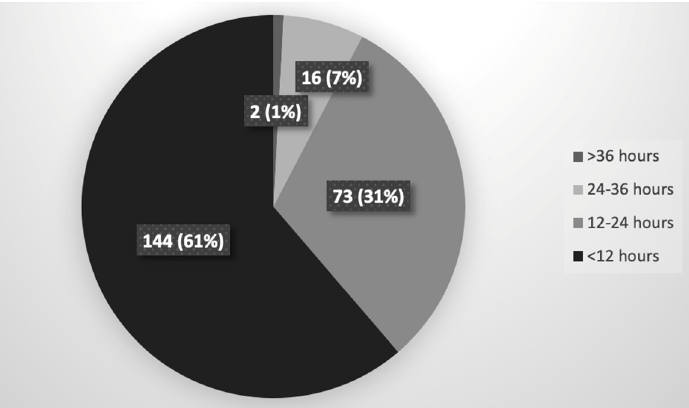
Figure 2. Timing of immunoprophylaxis (vaccine + HIBG at the same time).